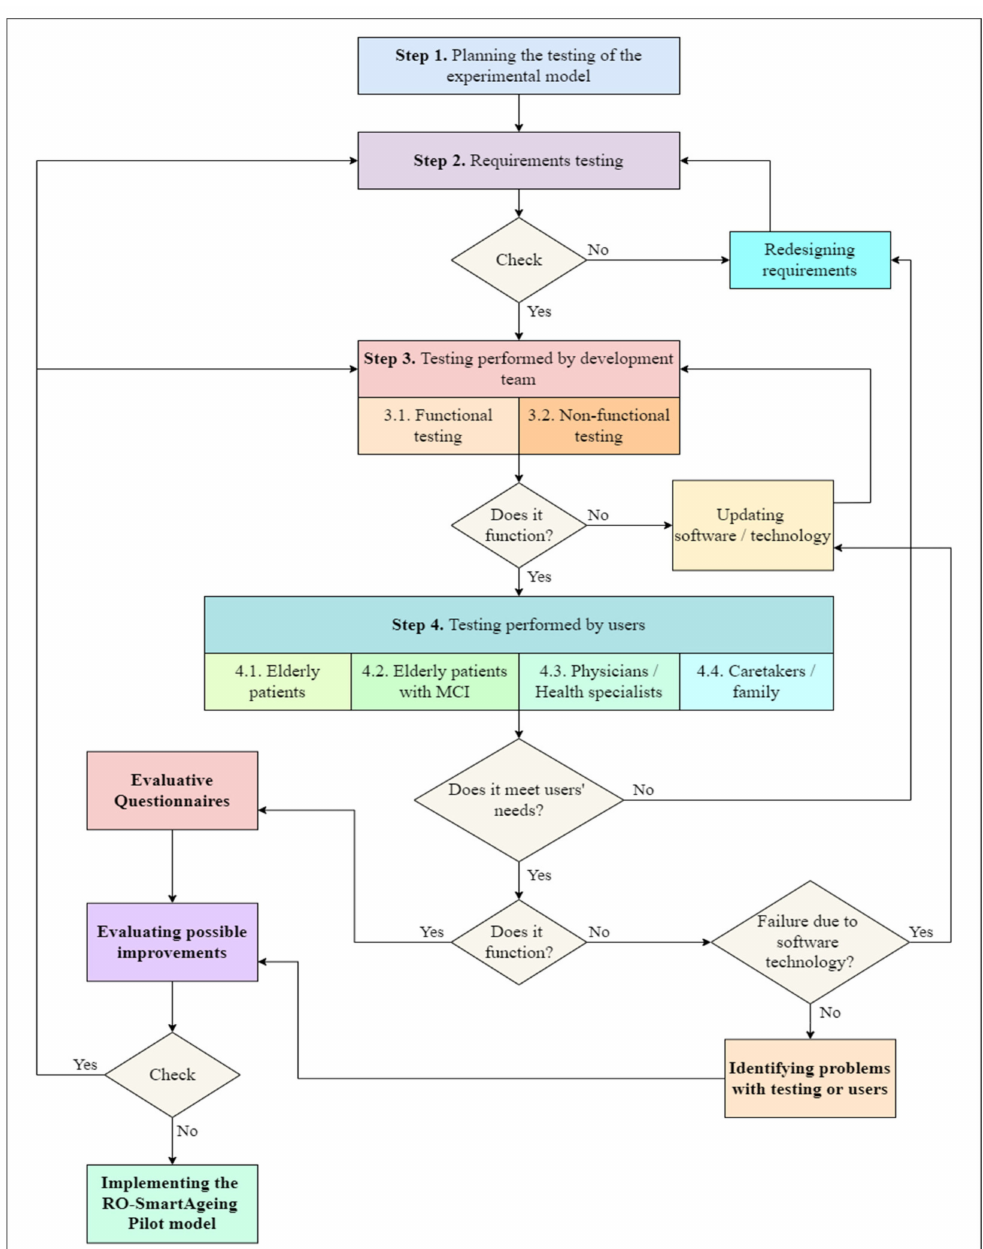
Figure 13. Algorithm for organizing the testing process of the RO-SmartAgeing